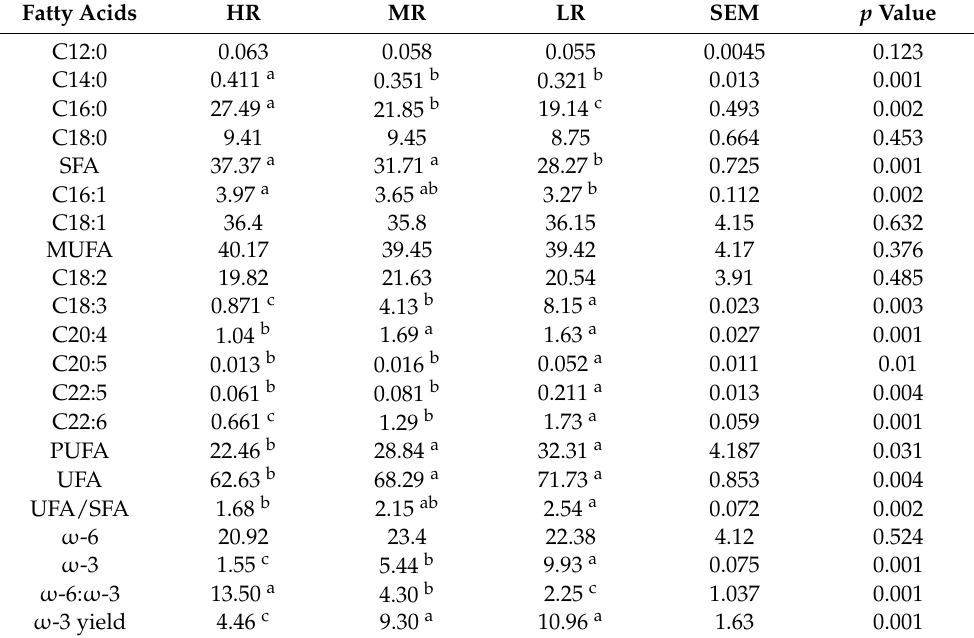
Table 7. Effect of ω -6/ ω -3 ratio on egg yolk fatty acids profile (%) of laying hens. Fatty Acids HR MR LR SEM C12:0